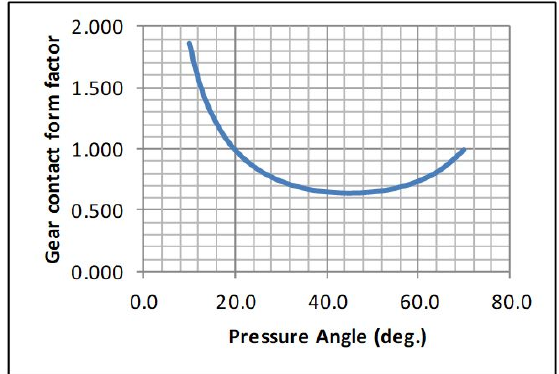
Fig. 4: Gear contact stress form